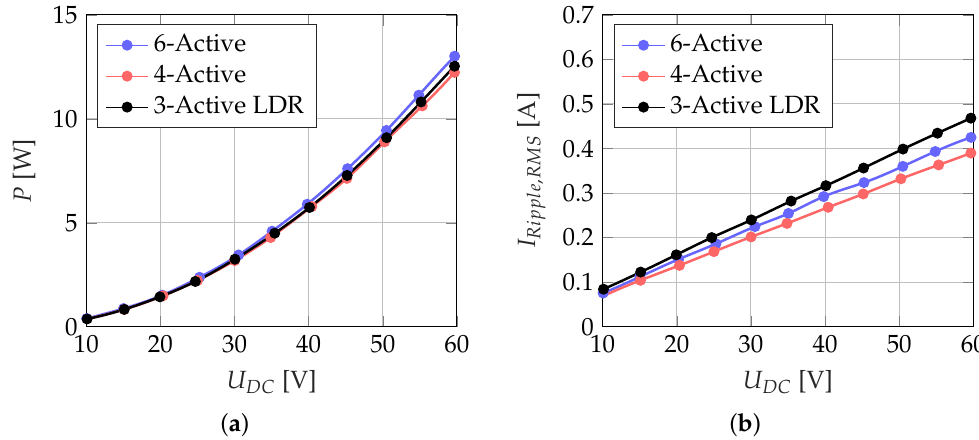
Figure 15. Comparison of the power losses in the bearing ( a ) and the current ripple of a phase ( b ) as a function of the DC-link voltage ( f PWM = 20 kHz, t inf =